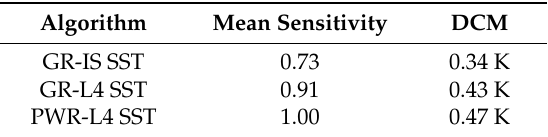
Figure 8 . Time series of the bias of T S − T S0 derived from GR-IS SST, GR-L4 SST, and PWR-L4 SST for 24–30 March 2018. Table 4. Mean sensitivities and magnitudes of the diurnal cycle, averaged from 1 to 31 March 2018, for the three explored algorithms.